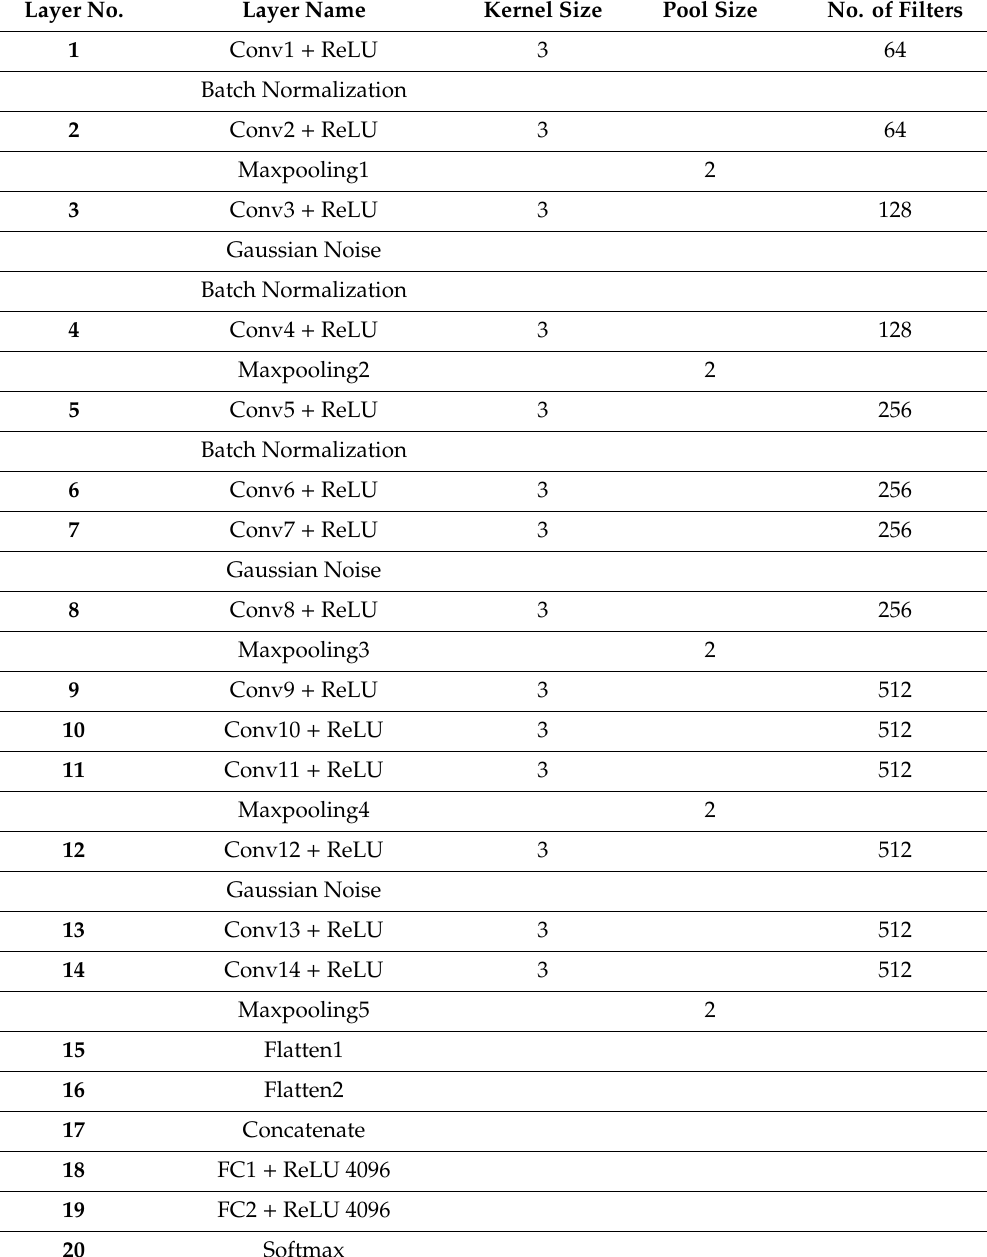
Table 1. Feature extraction and classification layers in the proposed SCNN